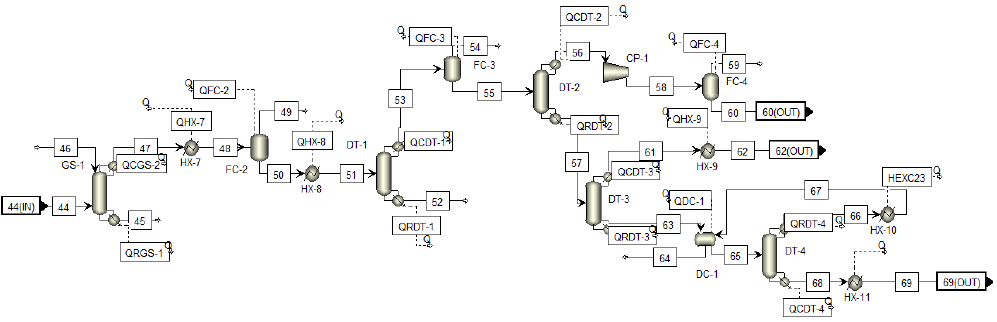
Figure 5. Separation stage flowsheet in topology 1.